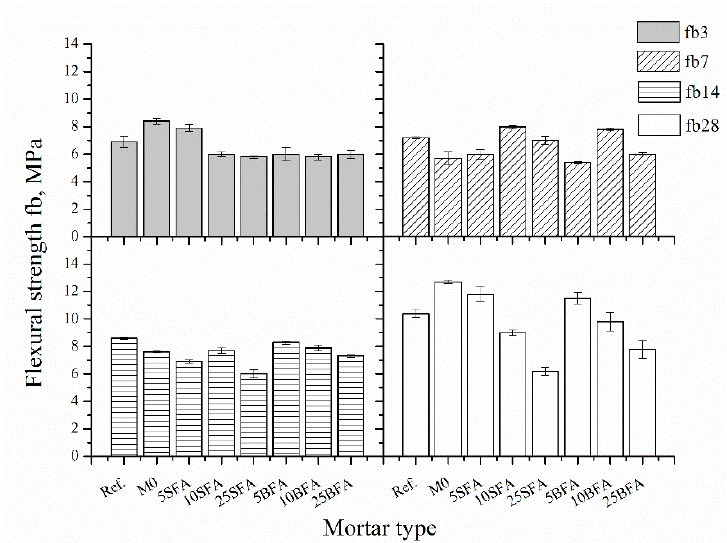
Figure 3. Flexural strength of tested mortars.